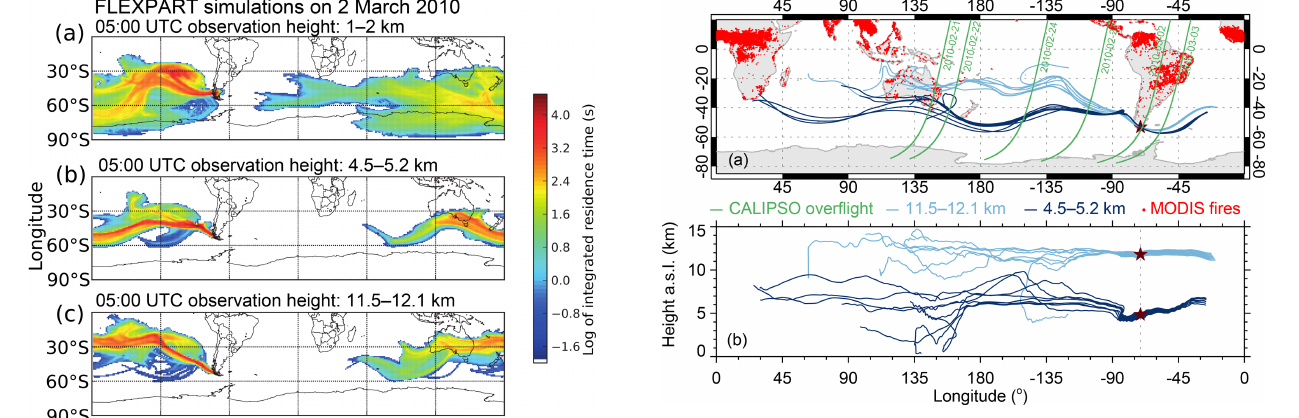
Figure 5. (a) Map of the HYSPLIT 13d backward trajectories for heights of 4.5 to 5.2km (blue) and 11.5 to 12.1km (light blue) ar- riving in Punta Arenas (brown star) on 2 March 2010, 09:00UTC: MODIS fire counts between 17 to 25 February 2010 (red dots) and CALIPSO tracks (green). (b) Height of the according